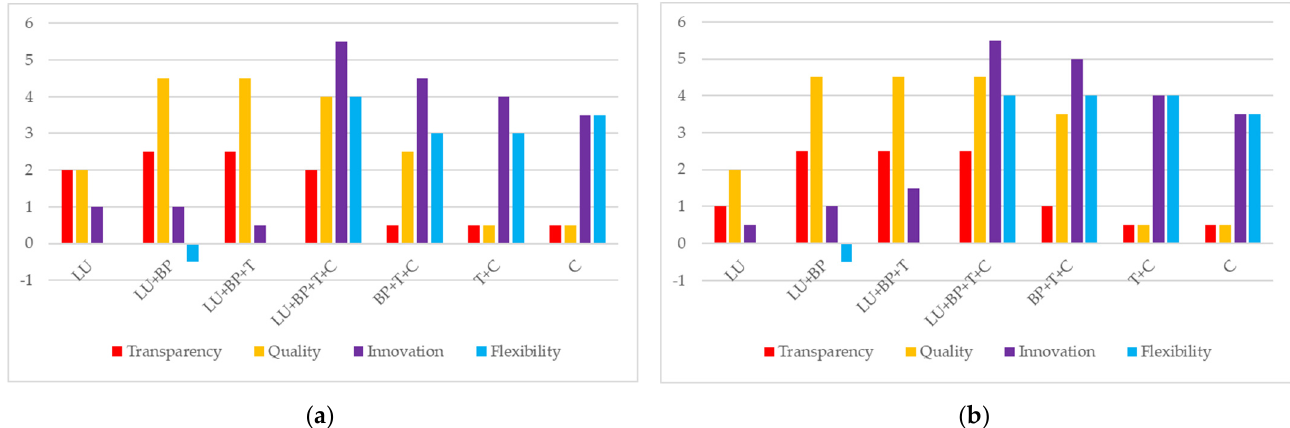
Figure 3. Ranking of competitive priorities per scenario based on results of Table 4 ( a ) for VC 1; and ( b ) for VC 2.